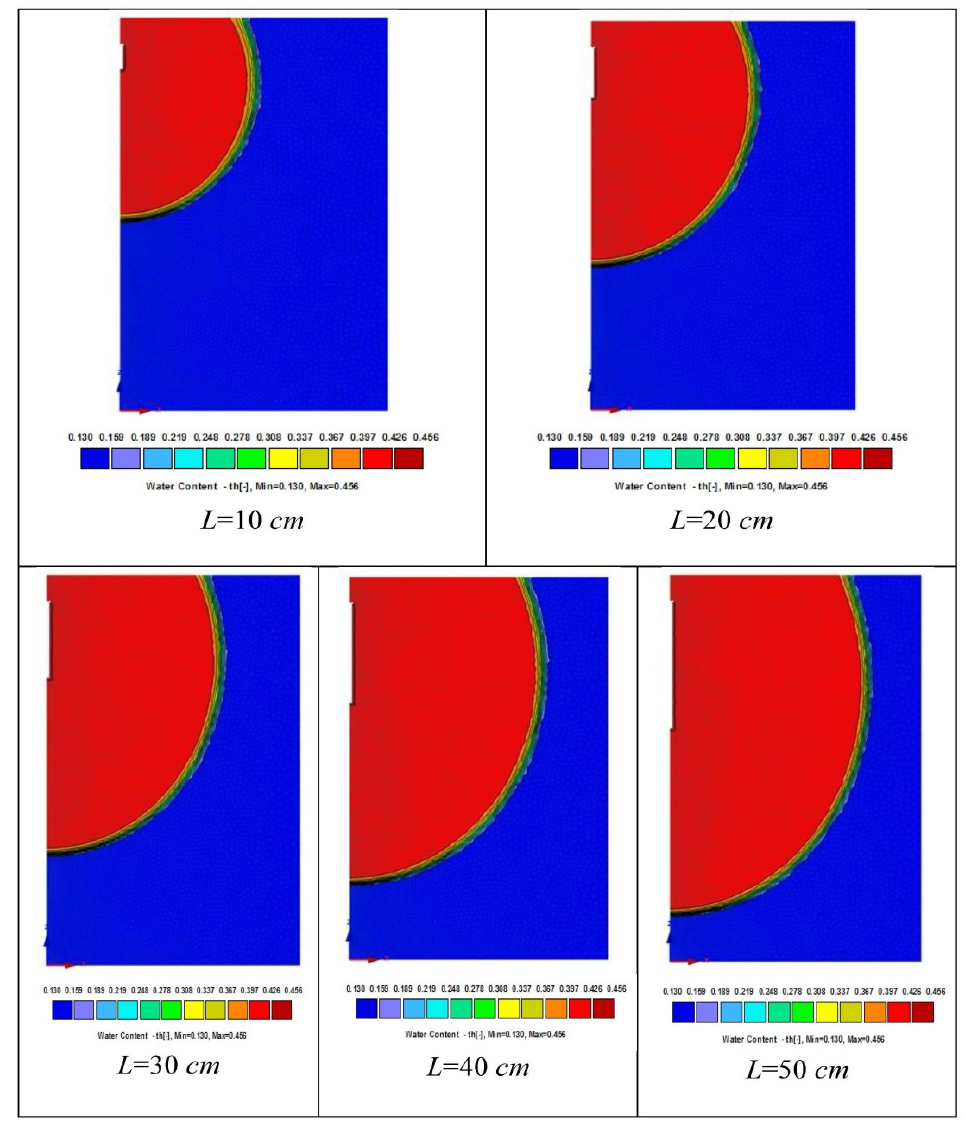
Fig. 5. Simulation of wetting patterns from a ceramic pipe in sandy loam soil with 1.0 x1.5 m domain, initial soil water content= 0.13cm 3 /cm 3 , pipe hydraulic conductivity=0.3 cm/hr, applied head=200 cm, and with different pipe lengths after 1.5 hr.